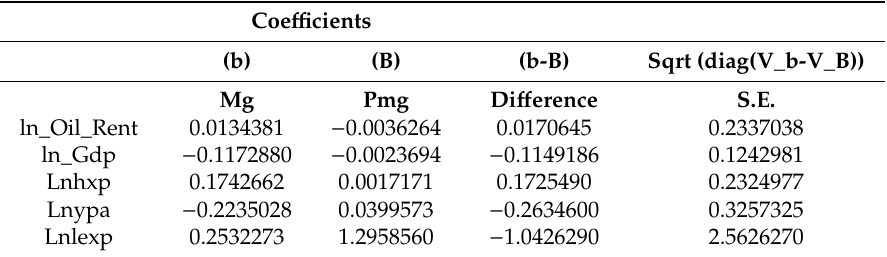
Table 6. Hausman (1978) Test.